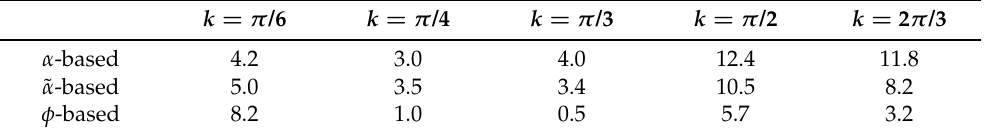
Table 3. Percentage error (100 × predictions for We =